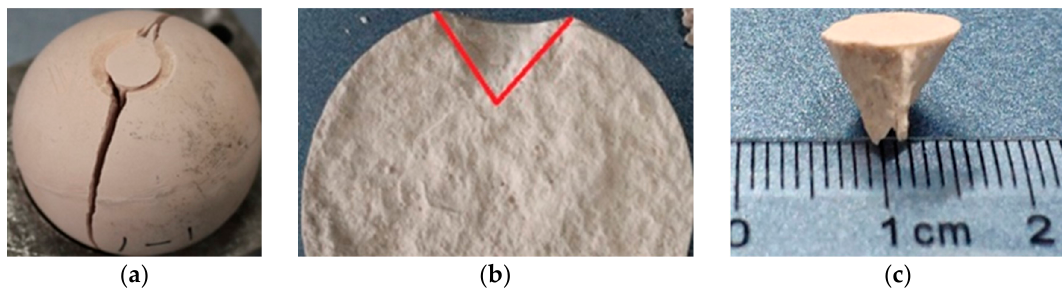
Figure 6. Morphologies after breakage: ( a ) contact point; ( b ) cone area; and ( c ) cone core.